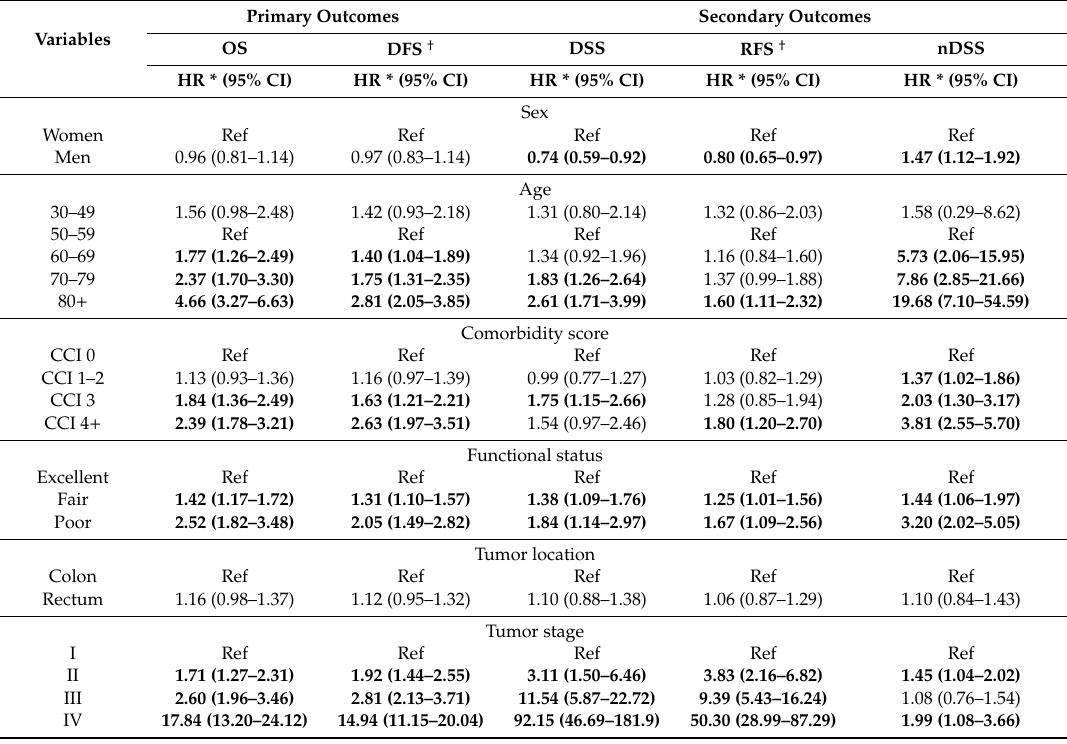
Table 2. Association of patient and tumor characteristics with survival outcomes in the training set.